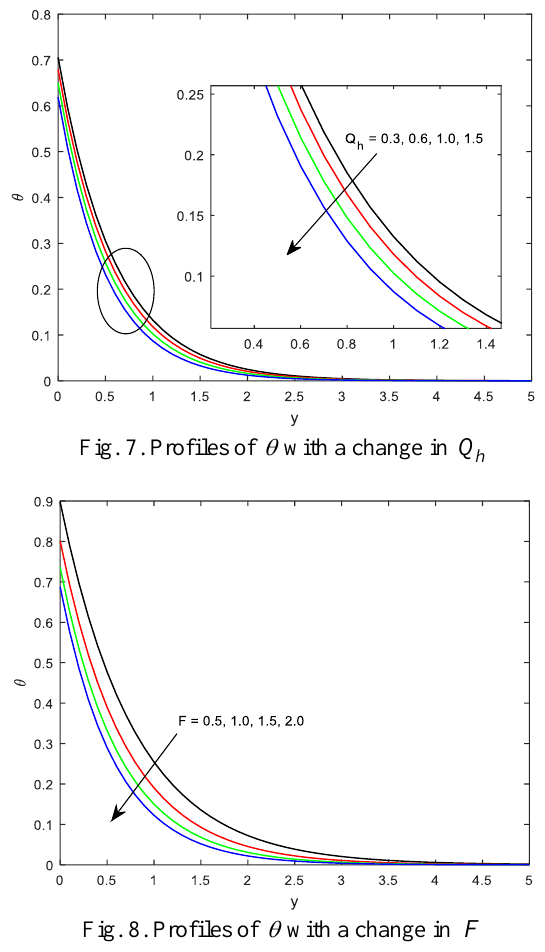
Fig. 8. Profiles of  with a change in F